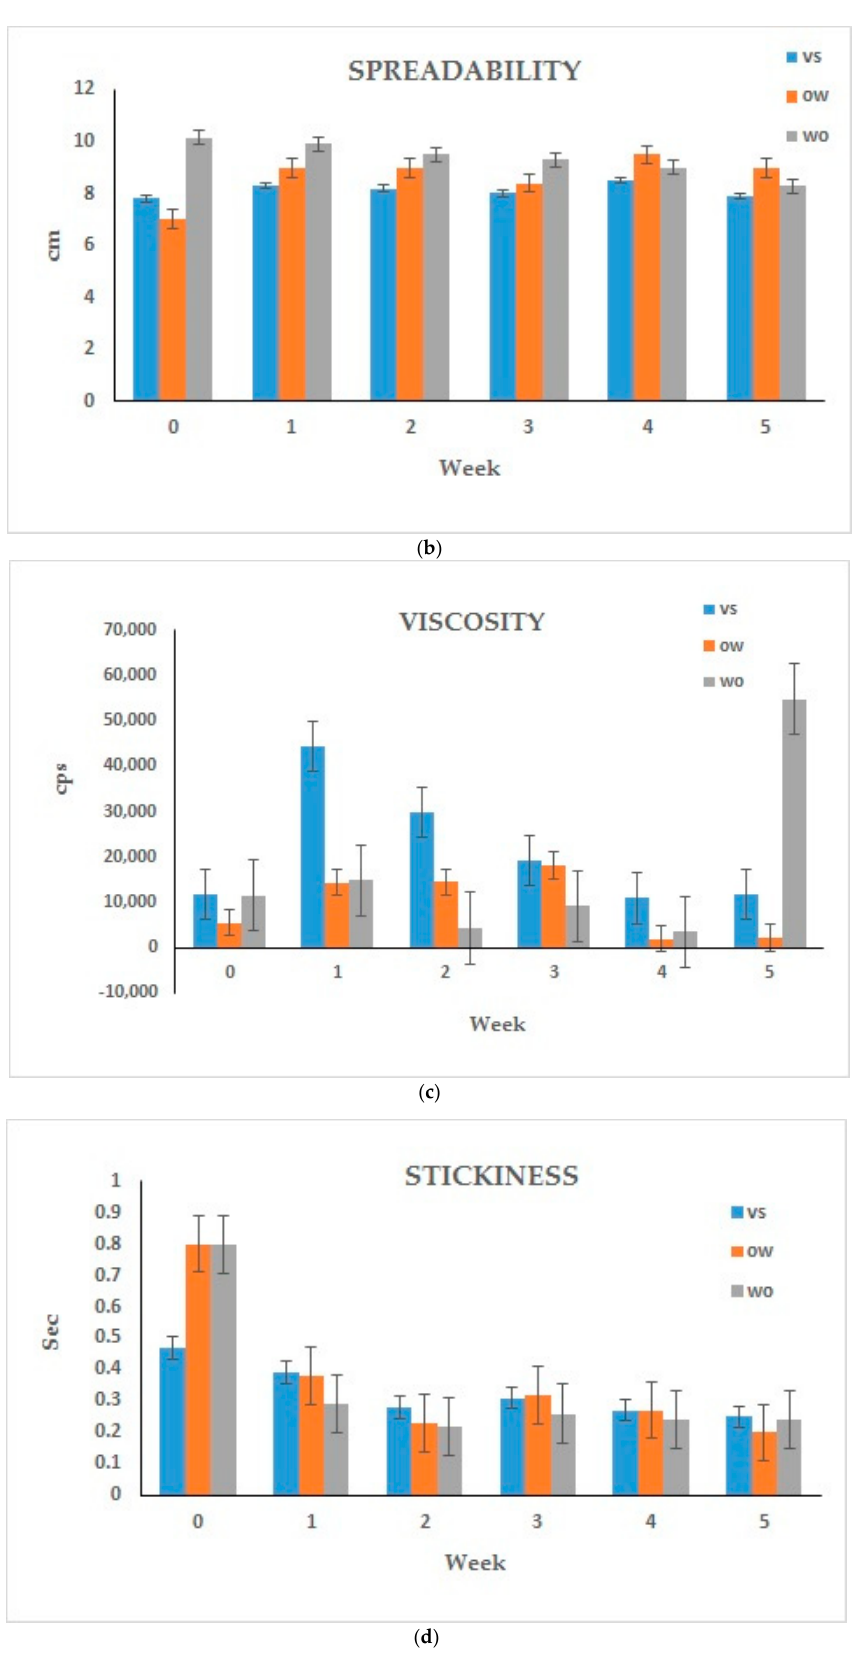
Figure 3. Evaluation of cream stability ( a ) pH; ( b ) spreadability; ( c ) viscosity; ( d ) stickiness.